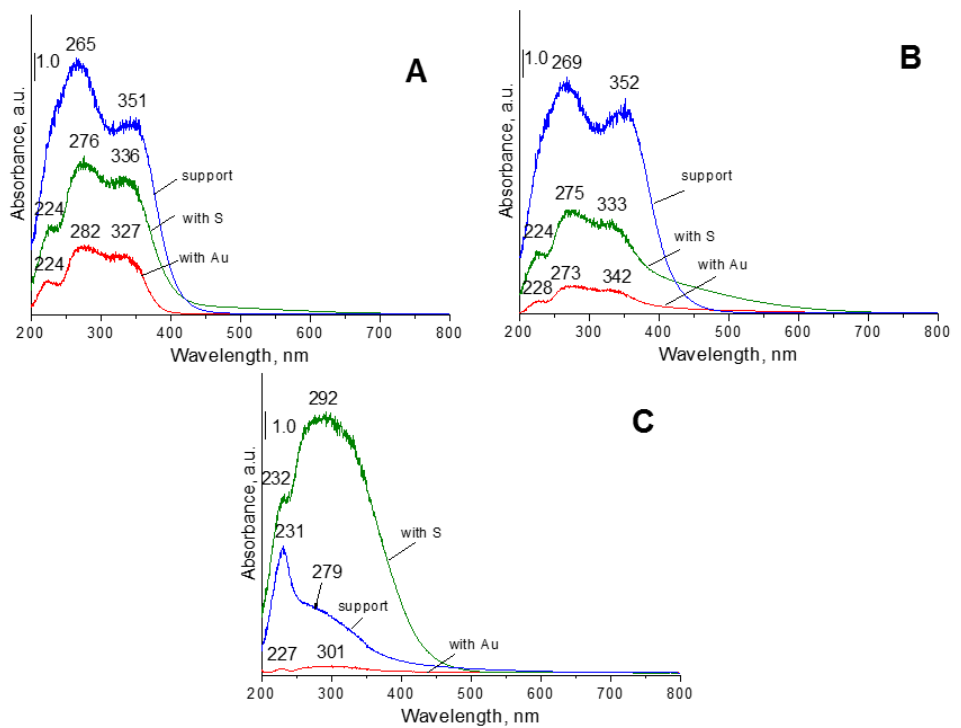
Figure 6. Ultraviolet-Visible Spectroscopy (UV-vis) spectra of selected materials (( A ) ceria CeO 2 ; ( B ) ceria-zirconia Ce x Zr y O z (1:1); ( C ) zirconia ZrO 2 ) before (blue line) and after (green line) modification of H 2 S and after Au deposition (red line).